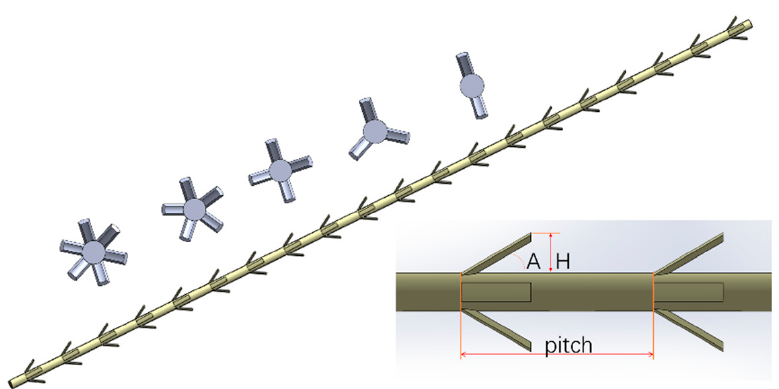
Figure 1. A geometrical model of insert. Table 1. Parameters of insert.